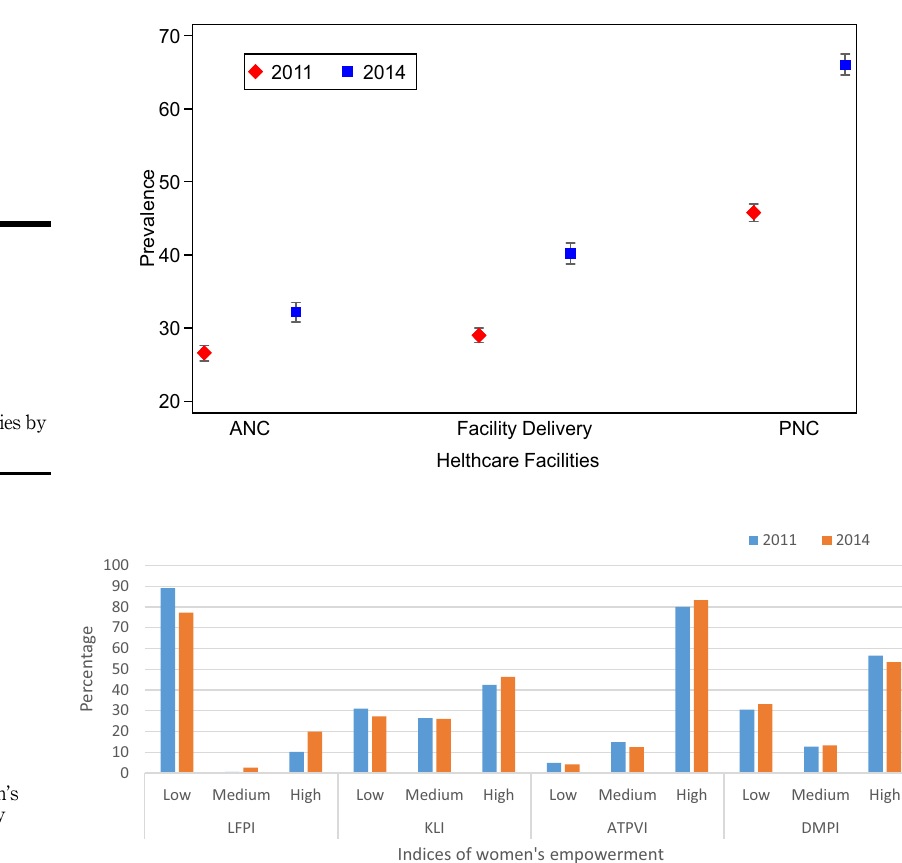
Figure 2. Indices of women ’